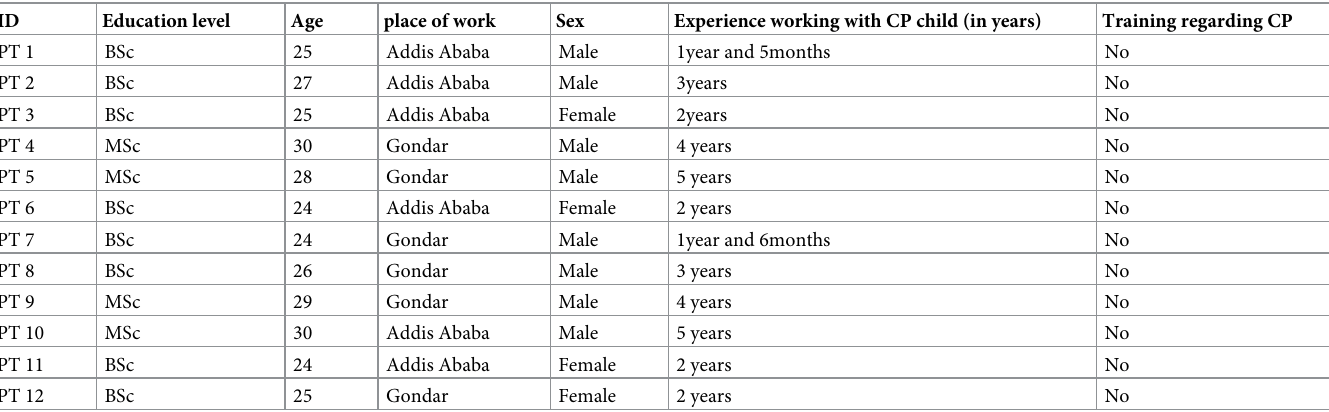
Table 2. Sociodemographic factors of